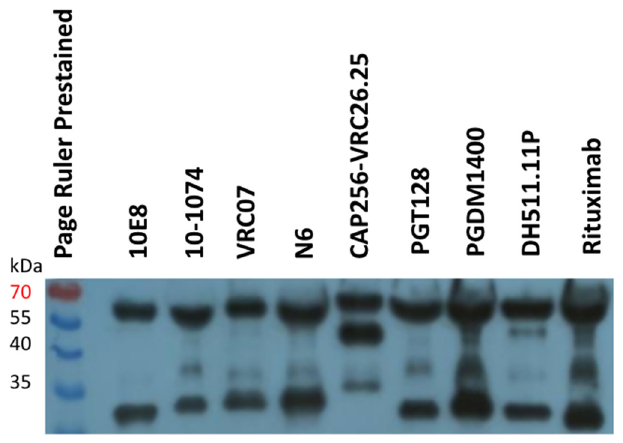
Figure 3. Western blot analysis of broadly neutralizing antibodies under reducing conditions.